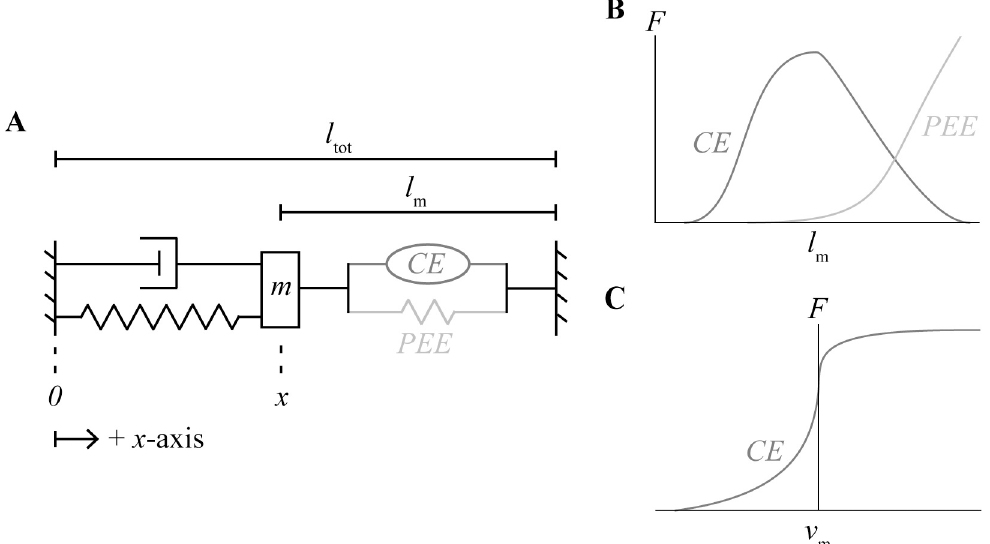
Fig 1. Visualization of modelling framework. Second-order dynamic system composed of a Hill-type muscle model in series with a damped harmonic oscillator (A). The force of the muscle is given by the sum of the active force due to the contractile element (CE) as a function of its length (B) and velocity (C), and the passive force due to the parallel elastic element (PEE) as a function of its length (B).